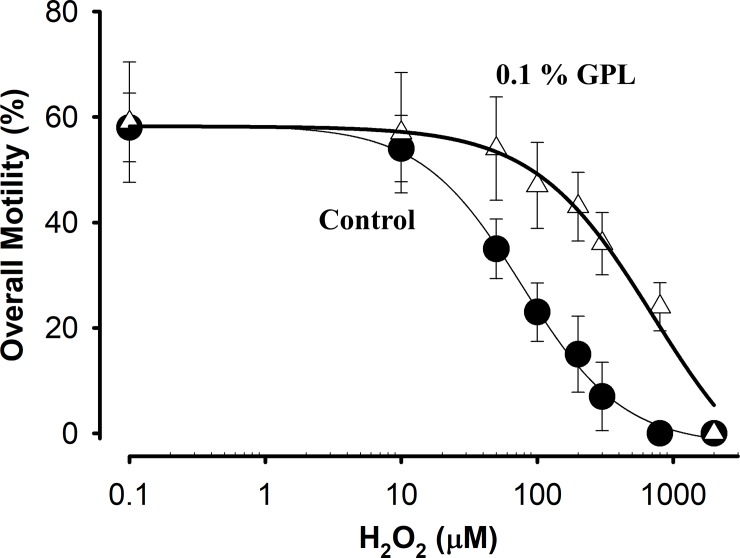
Dose response curves of overall motility versus hydrogen peroxide concentration.The data correspond to the average motility obtained after incubation in the presence of varying concentrations of H2O2 (solid circles) or in the presence of varying concentrations of H2O2 with 0.1% GPL added (open triangles) (n = 8 experiments). The solid lines represent the best fit of a Hill equation to the data.